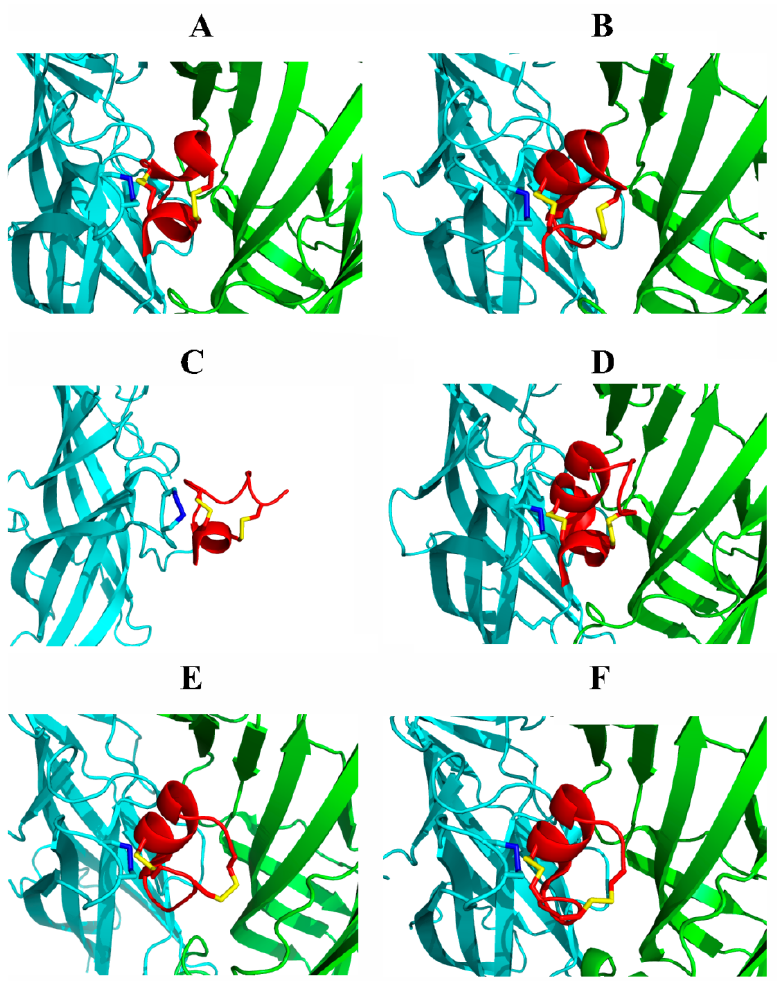
Figure 4. Ribbon representation of the ligand-binding sites in the structures of complexes of some α -conotoxins of different groups with homologues of nAChRs based on the X-ray data. ( A ) α 4/3- conotoxin ImI AChBP from A. californica (PDB 2C9T), ( B ) α 4/4-conotoxin BuIA AChBP from A. californica (PDB 4EZ1), ( C ) α 4/3-conotoxin RgIA extracellular domain of the α 9 subunit of human nAChR (PDB 6HY7), ( D ) α 4/7-conotoxin LvIA AChBP from A. californica (PDB 5XGL), ( E , F ) globular and ribbon isoforms of α 5/5-conotoxin AusIA AChBP from L. stagnalis (PDB 7N0Y and 7N0W). In all cases (except for the monomeric domain), only two adjacent protomers of AChBP pentamer are represented, the principal side being colored cyan, and the complementary side colored green. All conotoxins are colored red with yellow disulfides. The vicinal disulfide in C-loop of the principal side is colored blue.